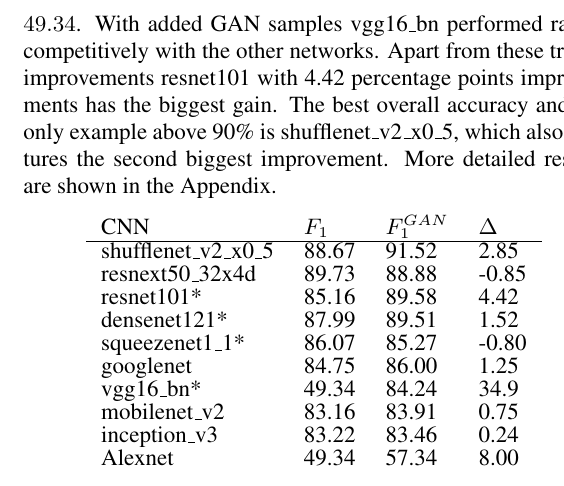
Table 1. Results of the patch classification experiment sorted by highest score. All F 1 -scores are macro averaged (cmp. section 2.2). F 1 are the results using the classifier trained only on the training data. For F GAN